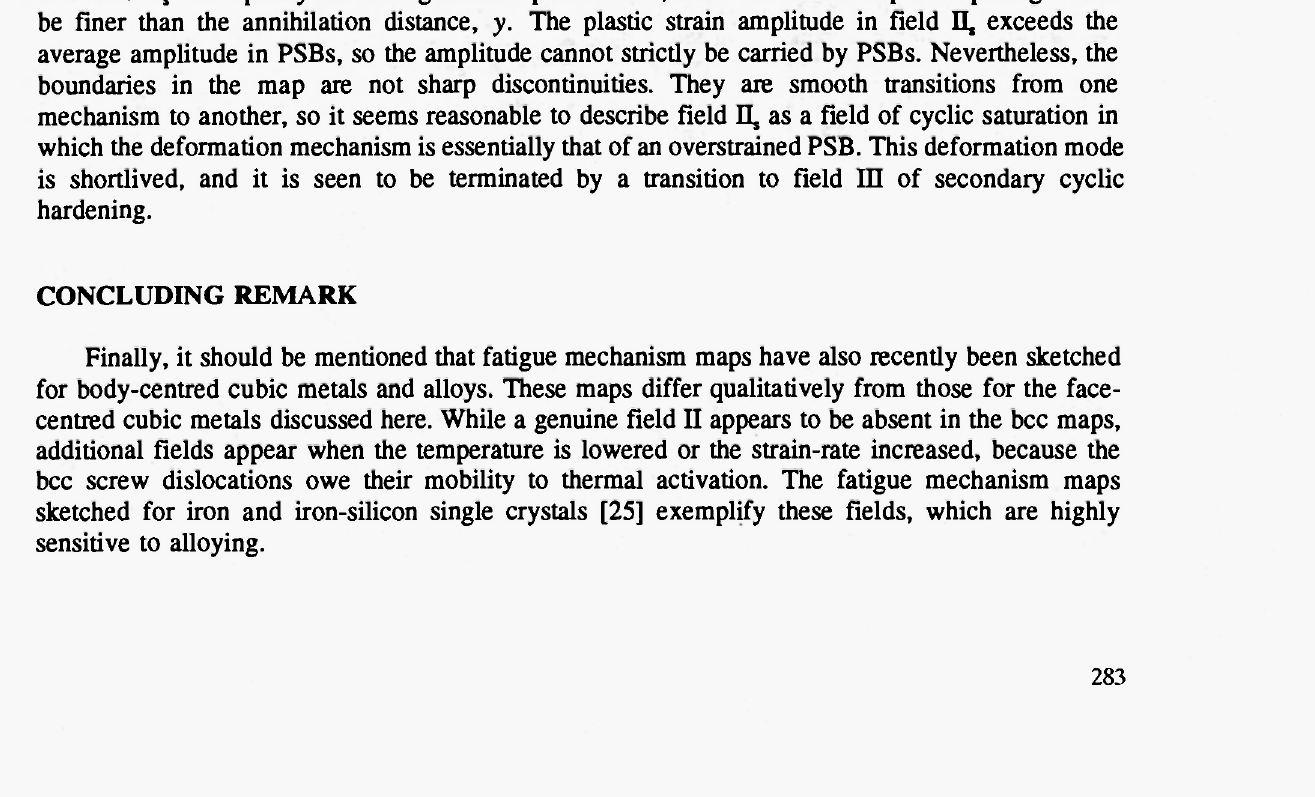
Fig. 7. The temperature dependences of x for z and x,, can be found in [24] and [2], m Sfl